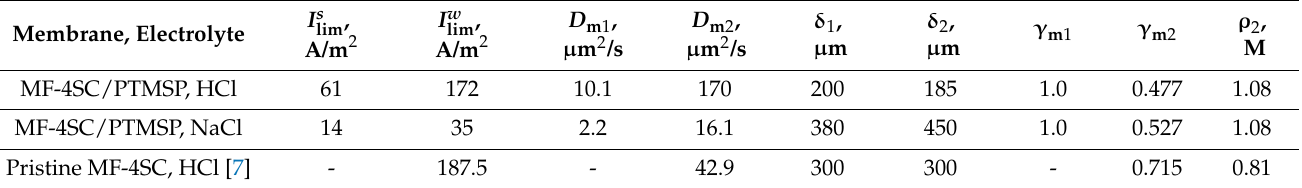
Table 3. Theoretically calculated parameters for both layers of the bilayer, and pristine